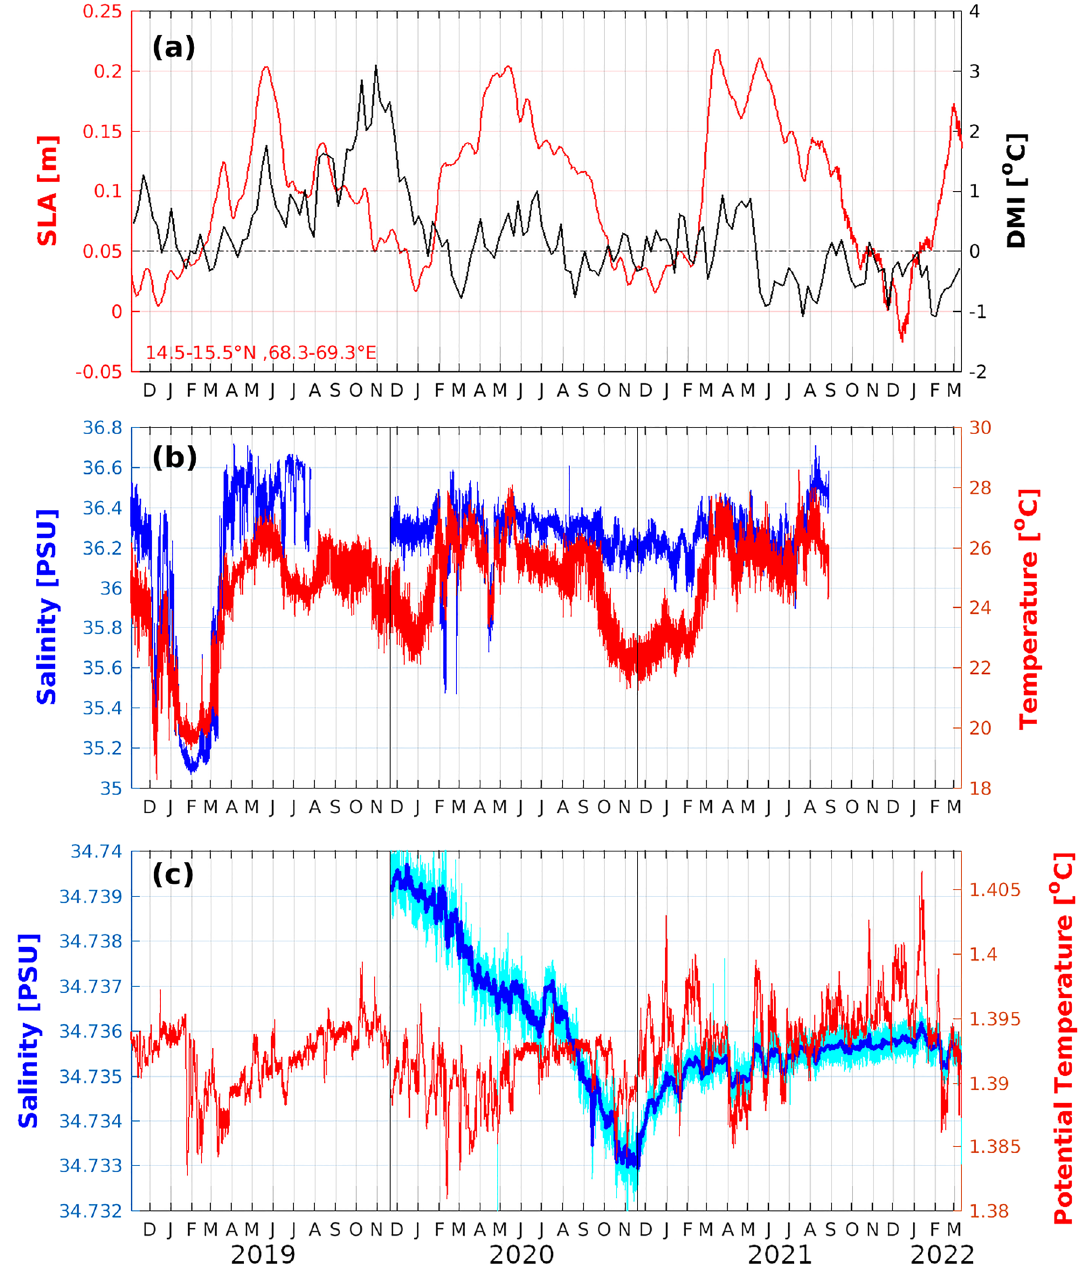
Figure 2. Time series from November 2018 to March 2022 showing ( a ) sea level anomaly in meters averaged in the area bounded by latitudes 14.5–15.5° N and longitudes 68.3–69.3° E (red) and Dipole Mode Index (black). ( b ) Moored buoy observation at 15° N, 68.8° E depicting average temperature in °C (red) and salinity in PSU (blue) in depth from 75 to 100 m. ( c ) Near-seabed time-series depicting15-minute interval potential temperature adjusted to 4500 dBar (θ 4500 ), in °C (red) and 3-day running mean of salinity in PSU (blue) while the 15-min interval salinity data is given by cyan line. Black vertical lines in subplots ( b ) and ( c ) indicate the time of redeployment of